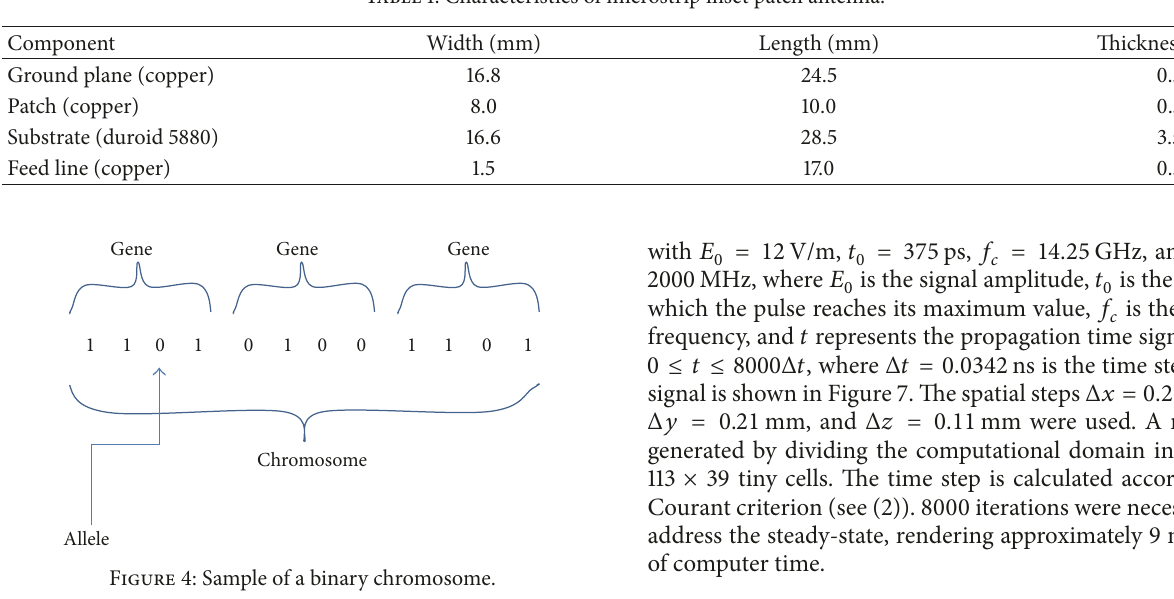
Figure 3: UPML layers around the FDTD mesh with (a) all layers and (b) removed frontal layers. The FDTD mesh is highlighted. Table 1: Characteristics of microstrip inset patch antenna.